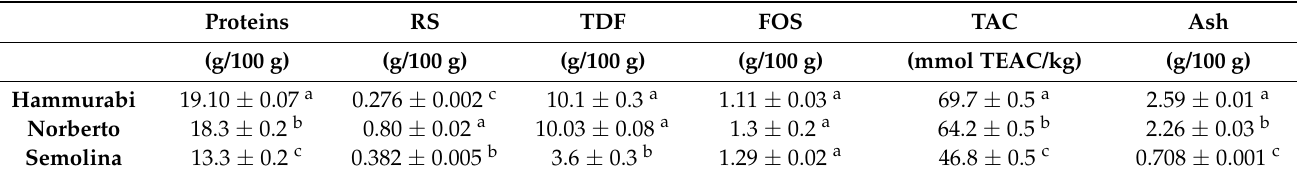
Table 1. Chemical traits and total antioxidant capacity of einkorn cv Hammurabi and cv Norberto and semolina cooked